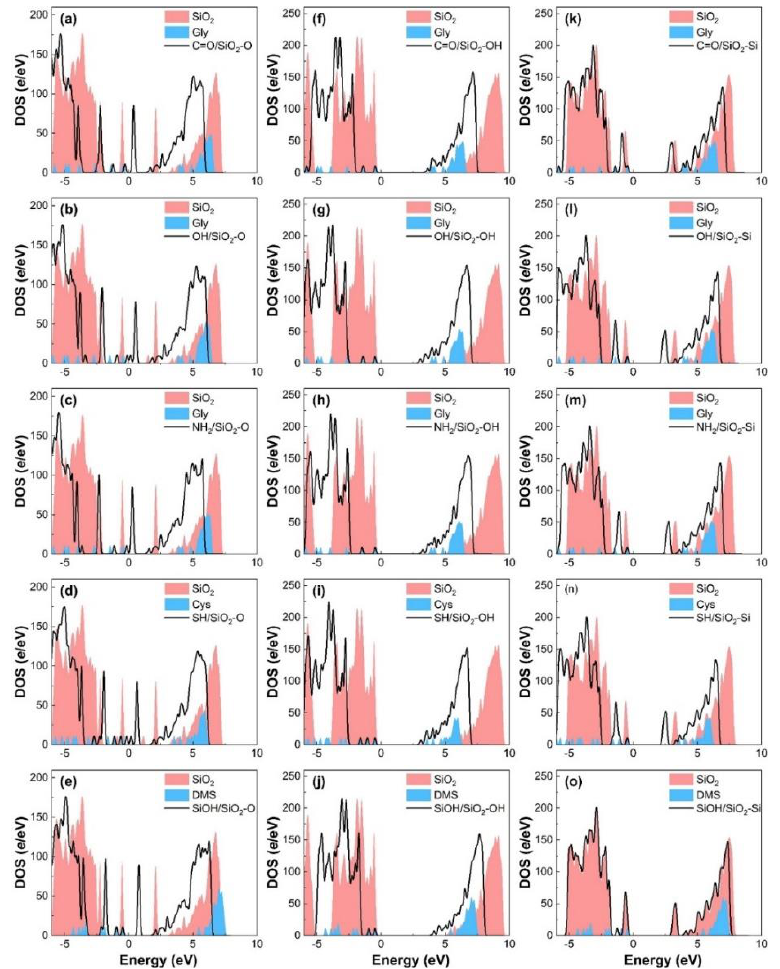
Figure 5. DOS of SiO 2 -O substrate with (black solid line) and without (red shadow) molecules’ ( a ) C=O, ( b ) OH, ( c ) NH 2 , ( d ) SH, and ( e ) SiOH group contact. DOS of SiO 2 -OH substrate with (black solid line) and without (red shadow) molecules’ ( f ) C=O, ( g ) OH, ( h ) NH 2 , ( i ) SH, and ( j ) SiOH group contact. DOS of SiO 2 -Si substrate with (black solid line) and without (red shadow) molecules’ ( k ) C=O, ( l ) OH, ( m ) NH 2 , ( n ) SH, and ( o ) SiOH group contact. The blue shadow denotes the DOS of the corresponding isolated molecule. The Fermi level is set to